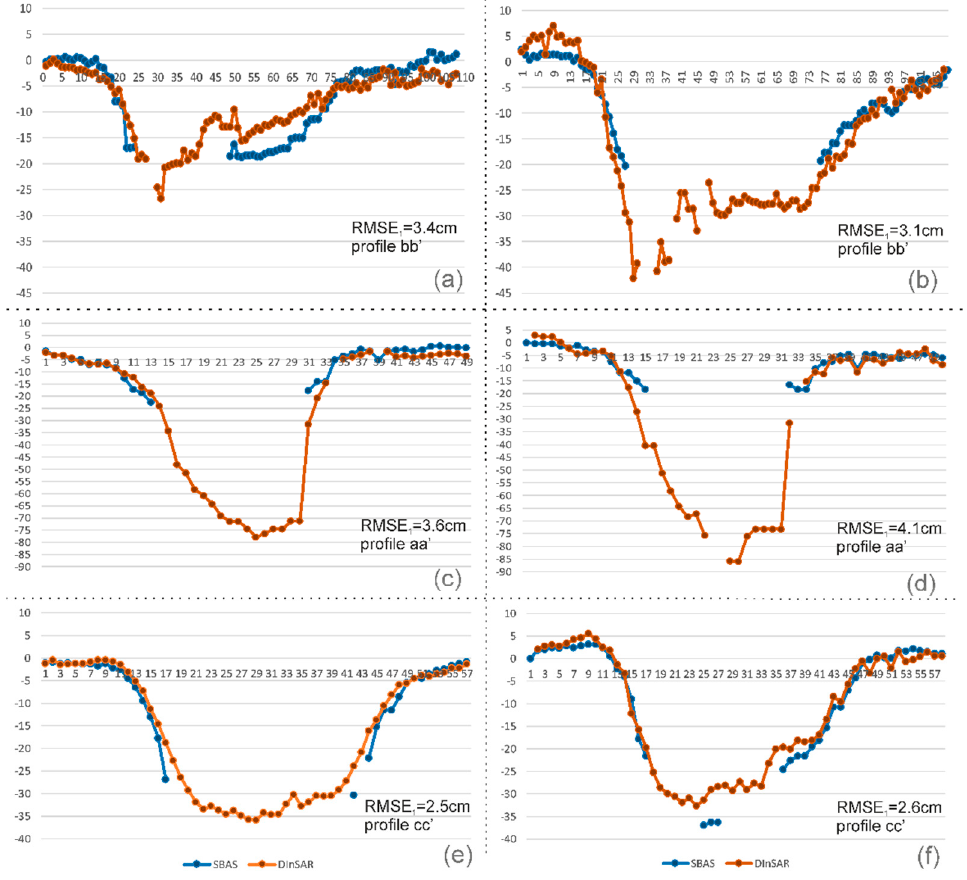
Figure 13. Displacement mutual authentication of the estimates of LOS displacement for the two di ff erent orbit modes (ascending—left; descending—right) and three diverse subsidence basins. The blue line represents the DInSAR results, while the green line represents SBAS results (in cm).